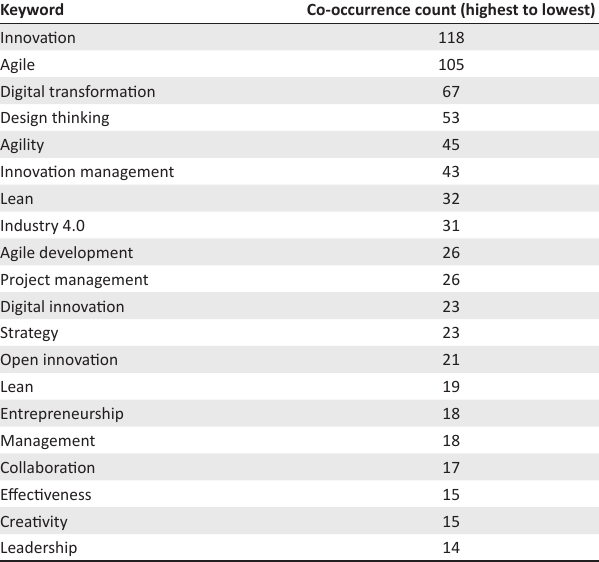
TABLE 1: Top 20 co-occurring keywords.